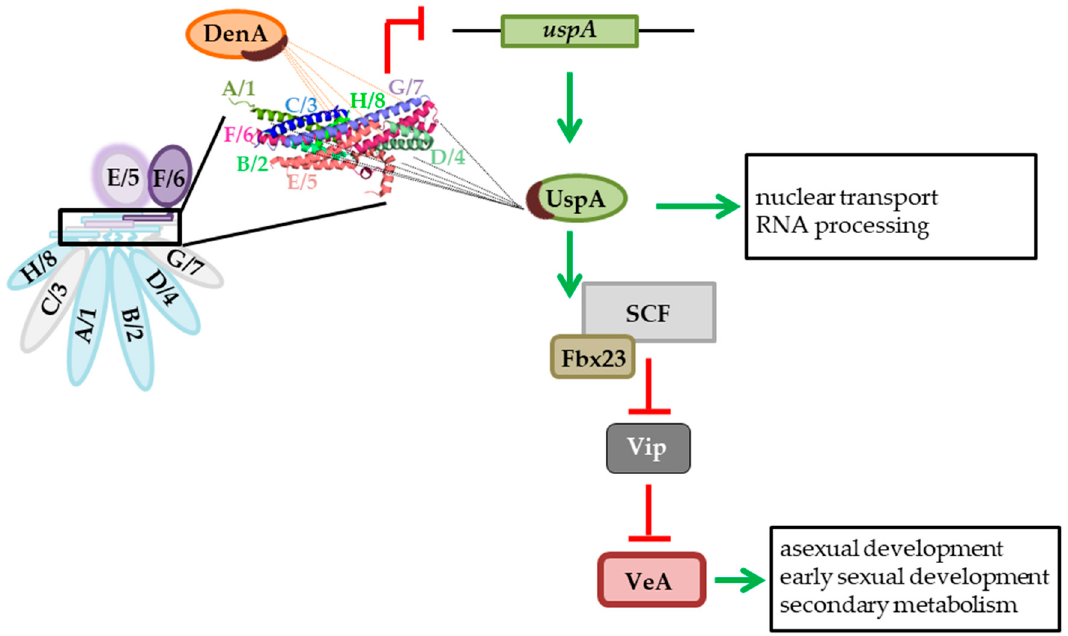
Figure 10. UspA interacts with the COP9 signalosome and influences the abundance of VeA. The deubiquitinase UspA interacts with six subunits of the COP9 signalosome (shown schematically in blue (PCI domain subunits) and in purple (MPN domain subunits)). The interaction surface of UspA might be at the helical bundle, where the C-terminal helices of all CSN subunits are connected. The crystal structure of the human COP9 signalosome was resolved in 2014 [22]. The model provided in the protein data bank (PDB 4d10) was edited with PyMOL 2.0 software and the C-terminal helices, which form the helical bundle, are shown here. The interaction surfaces of DenA and UspA with the COP9 signalosome are not mutually exclusive. The presence of an intact COP9 signalosome represses the gene expression of uspA . UspA co-purifies proteins related to nuclear transport or transcriptional processing. The presence of UspA and the presence of the Fbx23 leads to degradation of the key regulator of fungal development and secondary metabolism, VeA, after the initiation of multicellular development. A defect of UspA leads, therefore, to the delayed formation of developmental structures and to altered secondary metabolism. Whether VeA is targeted for ubiquitination by Fbx23 directly or if Fbx23 binds and, in turn, leads to ubiquitination of a VeA-interacting protein (Vip) remains to be addressed in future studies.